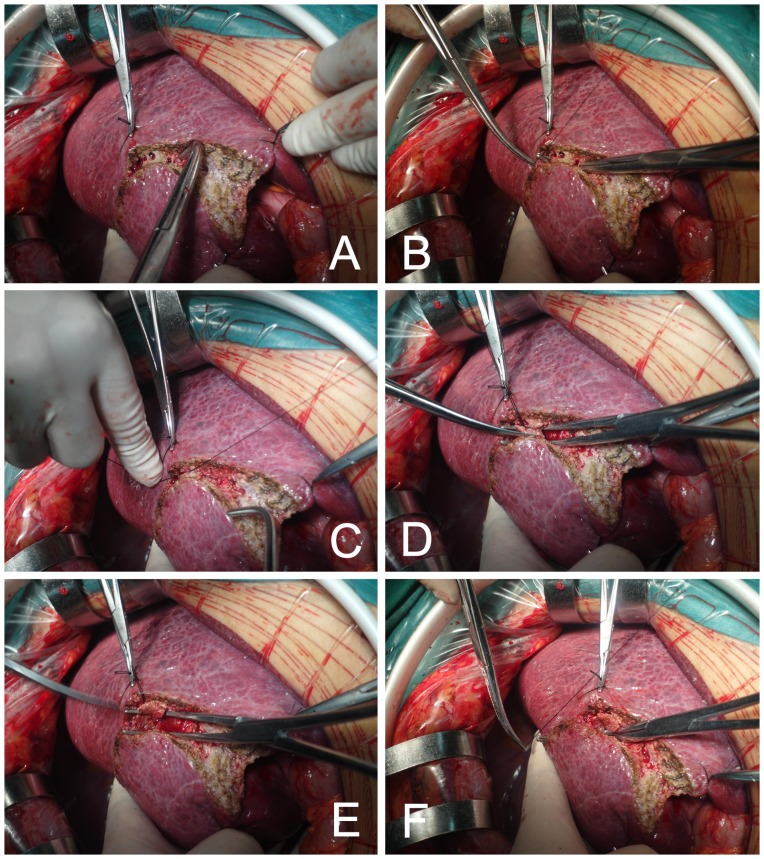
Hooking with ligation.A: The resection line was marked by electrocautery on the hepatic surface, B: The liver was dissected by rightangle forceps hooking the hepatic tissue; C, D, and E: Cannular structures were ligated and cut; F: Right-angle forceps hooked the hepatic tissue forward one by one.